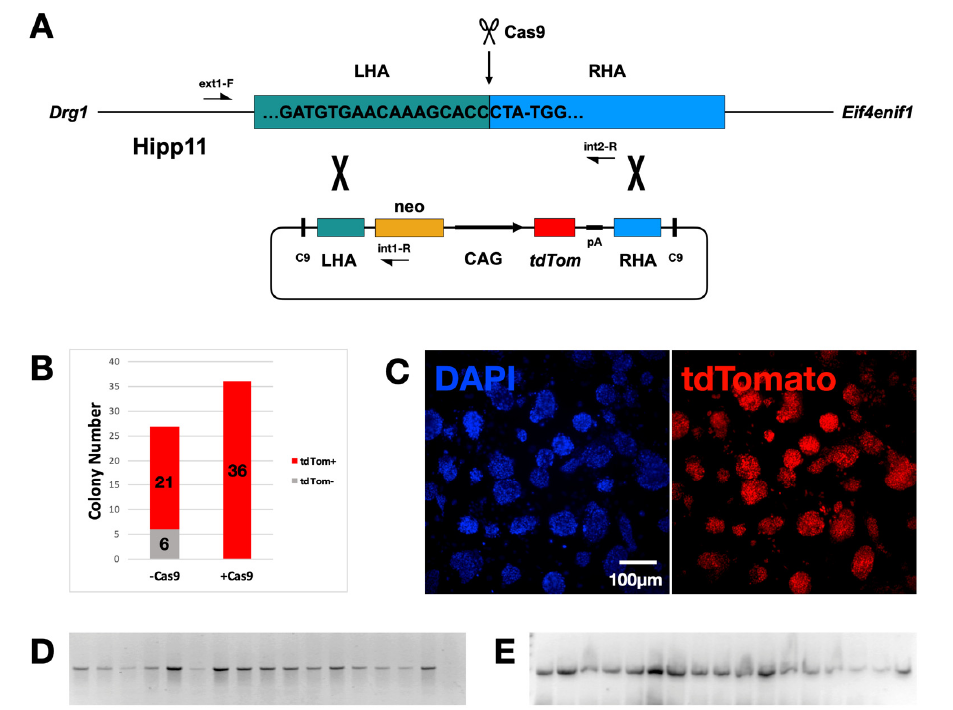
Figure 1. Generation of the “donor” ES cell line. ( A ) Schematic of the homologous recombination between the mouse Hipp11 genomic locus and the “donor” plasmid. Cas9 cleaves the target sequence in Hipp11, at a site 3 nucleotides upstream of the protospacer adjacent motif (PAM) -TGG, separating the left and right homology arms (LHA and RHA). The “donor” plasmid contains the neomycin resistance cassette (neo) and the tdTomato expression cassette (CAG promoter, tdTom gene and polyadenylation signal pA), flanked by the homology arms, which direct the homologous recombination. Two CRISPR/Cas9 target sites (C9), identical to the one in Hipp11, render the recombination event more efficient. ( B ) Bar graph showing the number of stably transfected mouse embryonic stem cell (mESC) colonies with and without fluorescence, in the presence and absence of CRISPR/Cas9 target sites (C9) in the “donor” plasmid (n = 3). ( C ) Stably transfected “donor” colonies showing red fluorescence. ( D ) Gel image showing genomic PCR analysis of 16 “donor” clones, using primers ext1- F/int1-R (indicated in Figure 1A). All clones have incorporated the plasmid in the correct position. Last lane: genomic DNA of cells, transfected without the Cas9/gRNA plasmid (negative control). ( E ) Gel image showing genomic PCR analysis of the 16 “donor” clones in Figure 1D, using primers ext1-F/int2-R (indicated in Figure 1A). All clones have incorporated the plasmid in one of the two alleles. Last lane: genomic DNA of untransfected cells (positive control). Primer sequences are listed in the Supplementary Material (Table